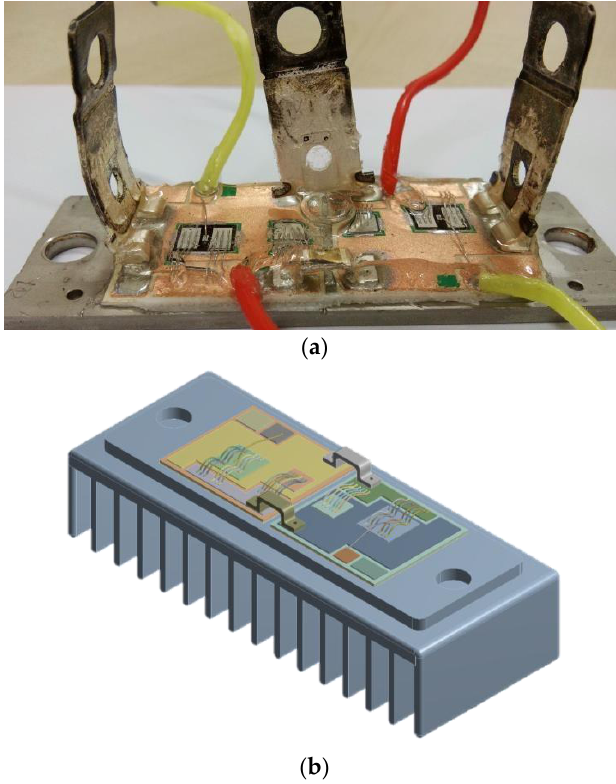
Figure 8. ( a ) IGBT module; ( b ) FEA model with a cold plate.